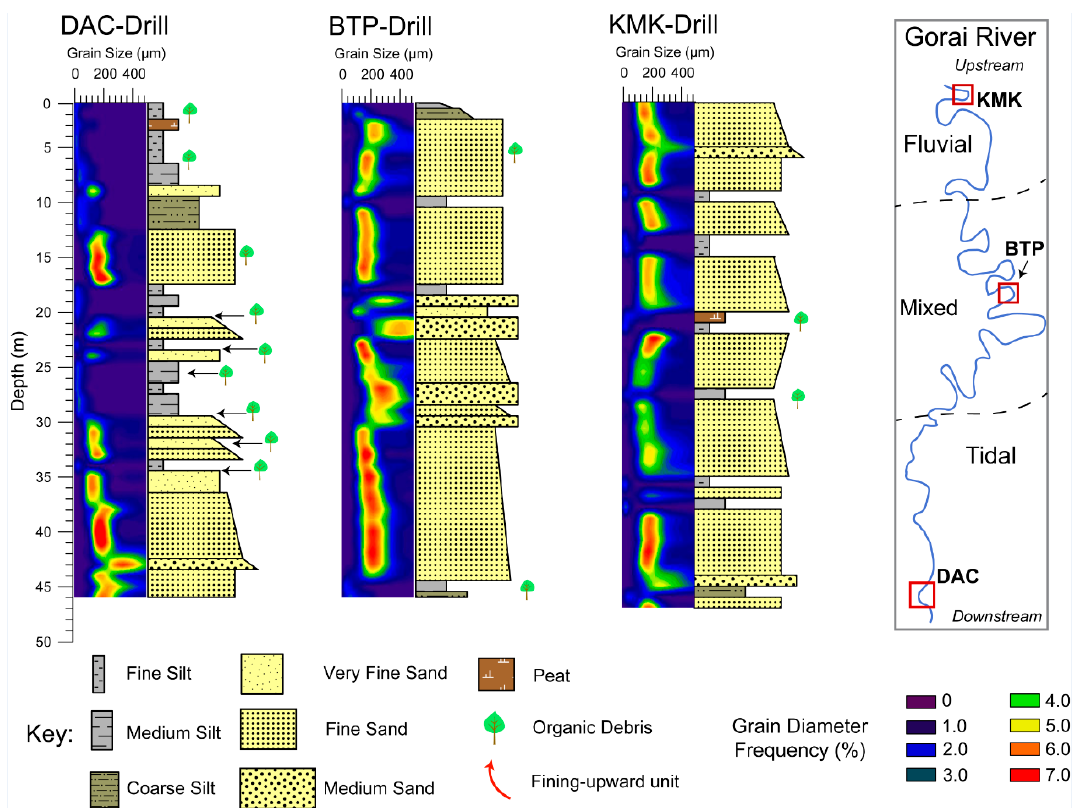
Figure 9. Drill core stratigraphy at DAC, BTP, and KMK point bars, representing tidal, mixed tidal-fluvial, and fluvial depositional settings. Note the change in scale for core depth relative to cores shown in Figures 5, 7, and 8.